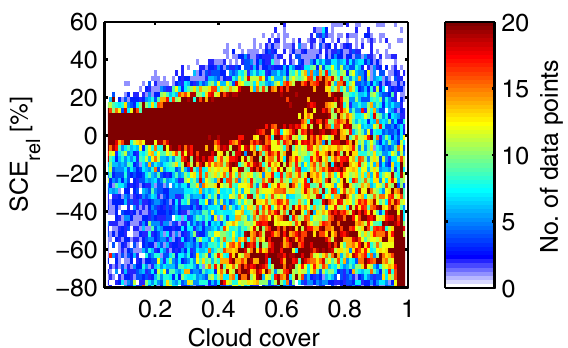
Figure 4. Density distribution of the dependence of SCE rel on cloud coverage for Davos for mid-level clouds (Cc–Ac). The den- sity colour distribution represents the number of data